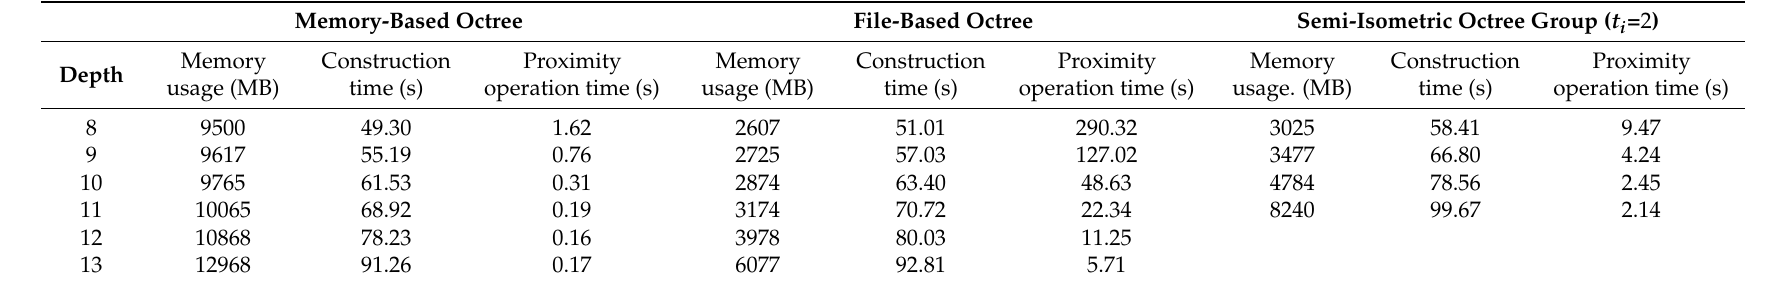
Table 7. Performance comparison among octree implementing methods using Data 1.